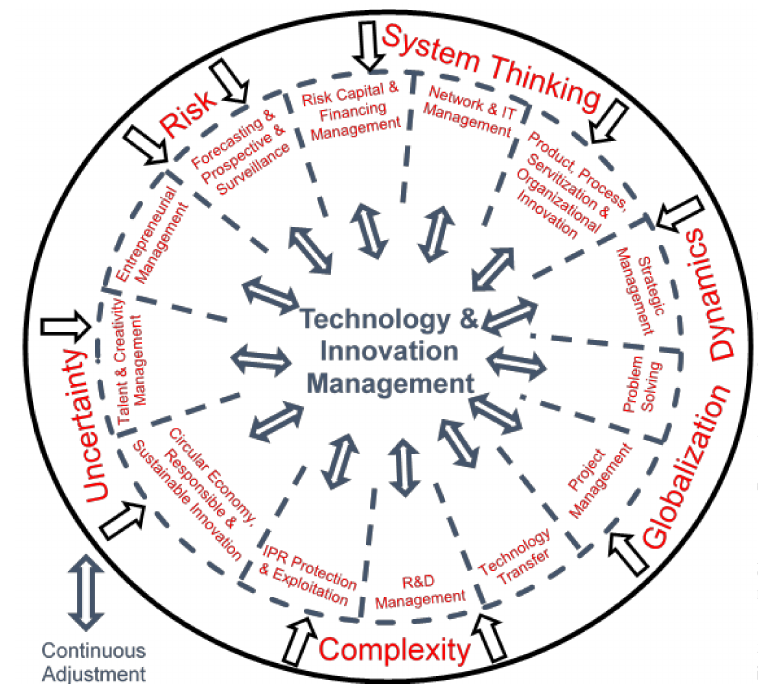
Figure 2. Model for Technology and Innovation Management. Source: own